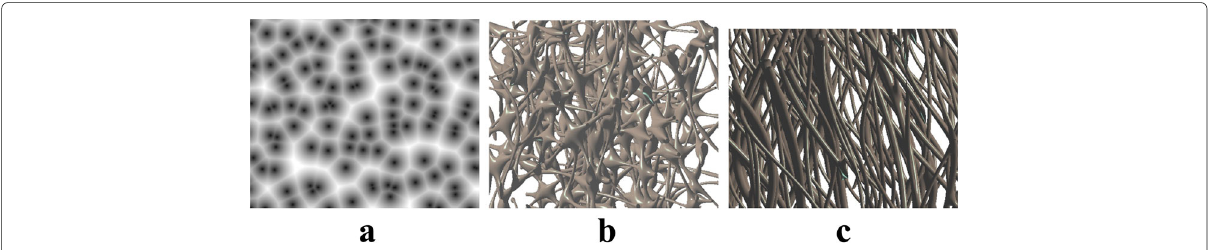
Fig. 12 Implicit geometric modeling of the biological neural system ( b ) and the vascular cluster ( c ) using some 2D distance functions ( a )